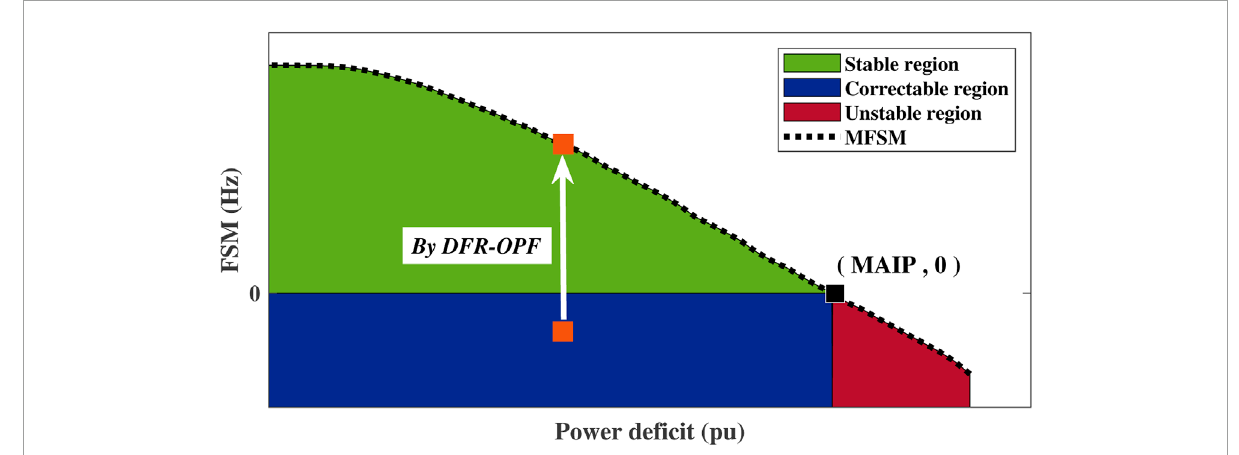
FIGURE 3 Region-wise graph for frequency security assessment.